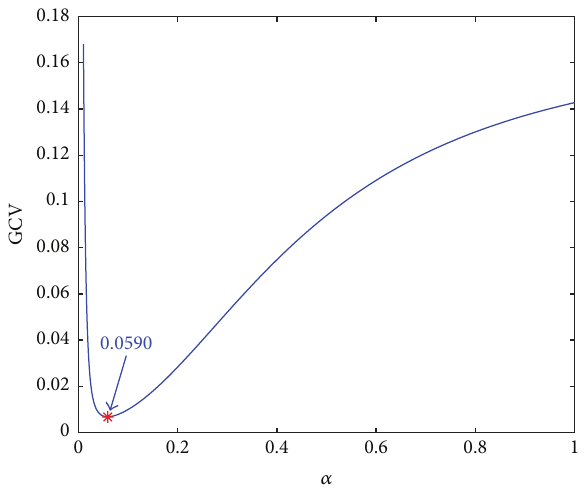
Figure 7: GCV for impact load identification of SISO system.